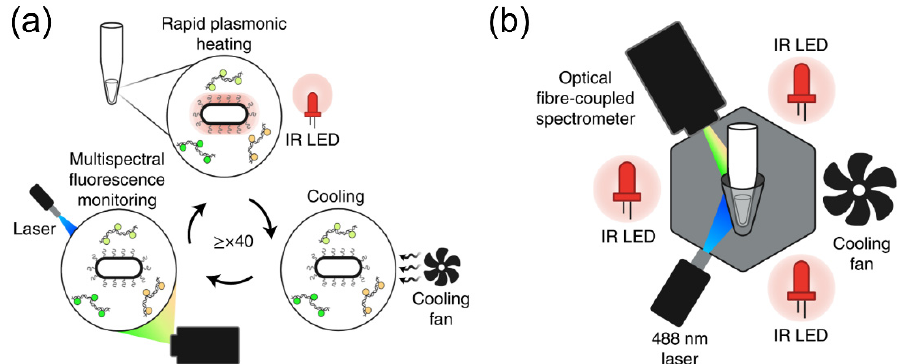
Figure 6. ( a ) Schematic of multiplexed real-time plasmonic reverse-transcriptase polymerase chain reaction. The Au nanorods are suspended in solution in a PCR tube, which can rapidly absorb light from the light source and convert it to heat, allowing for fast PCR thermal cycling. ( b ) Schematic illustration of the instrument. A PCR tube is surrounded by low-cost optical components. The main components of the instrument include a thin-walled PCR tube surrounded by three IR LED modules, a cooling fan, and a 488nm laser and spectrophotometer setup for fluorescence detection. Reprinted from [131], with permission from Springer